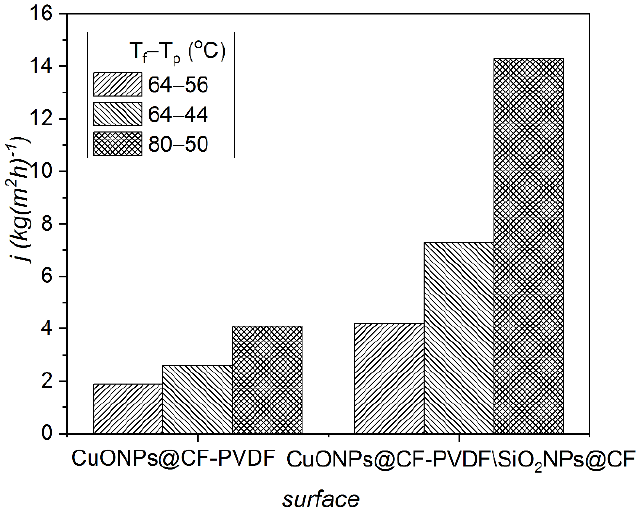
Figure 4. Performance of membranes at different ∆ T .